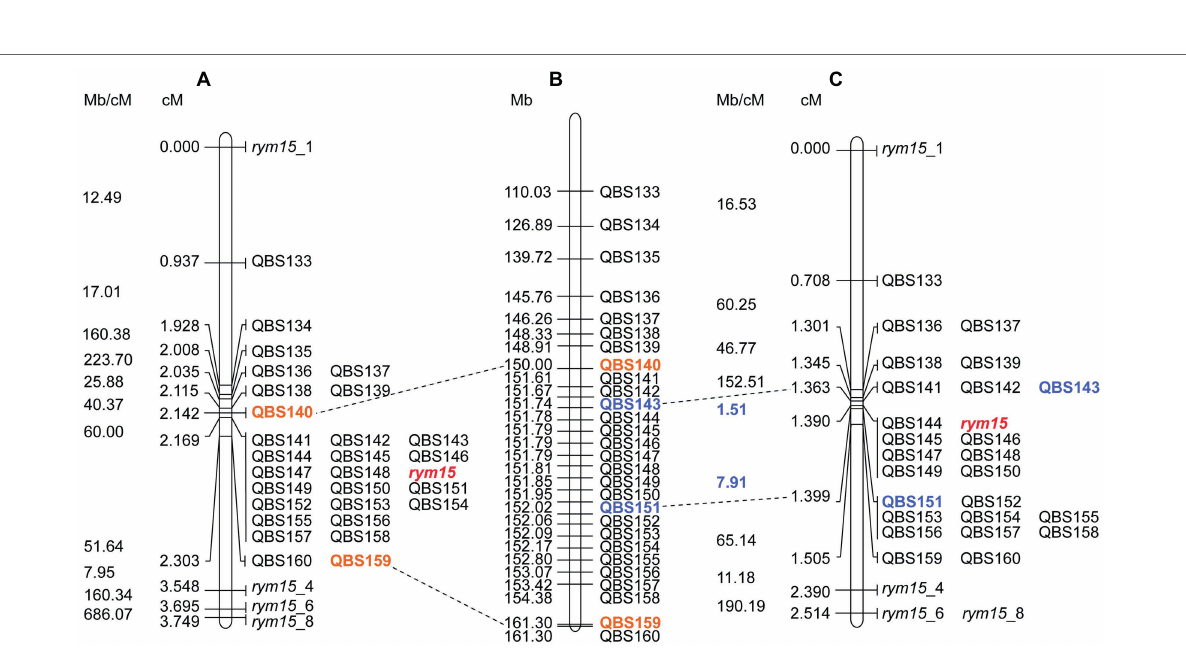
micro co-linearity between physical and genetic order of all used markers was consistent. In the other pan-genome accessions, the physical size of the target region ranged from 0.26 (Golden Promise) to 0.34 Mb (HOR3365; Supplementary Table S4 ).